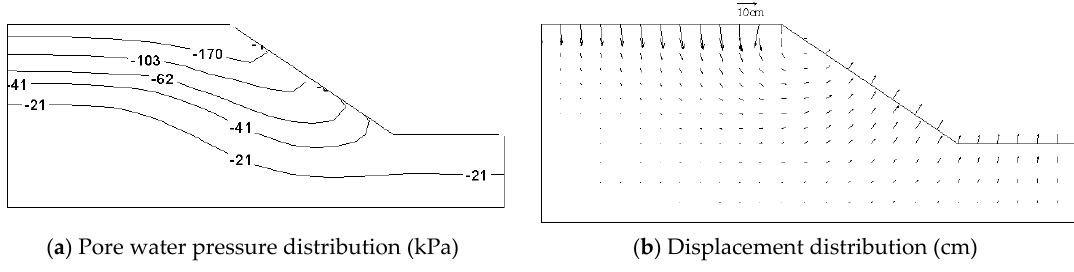
Figure 2. The distributions of pore water pressure and displacement at the end of evaporation.